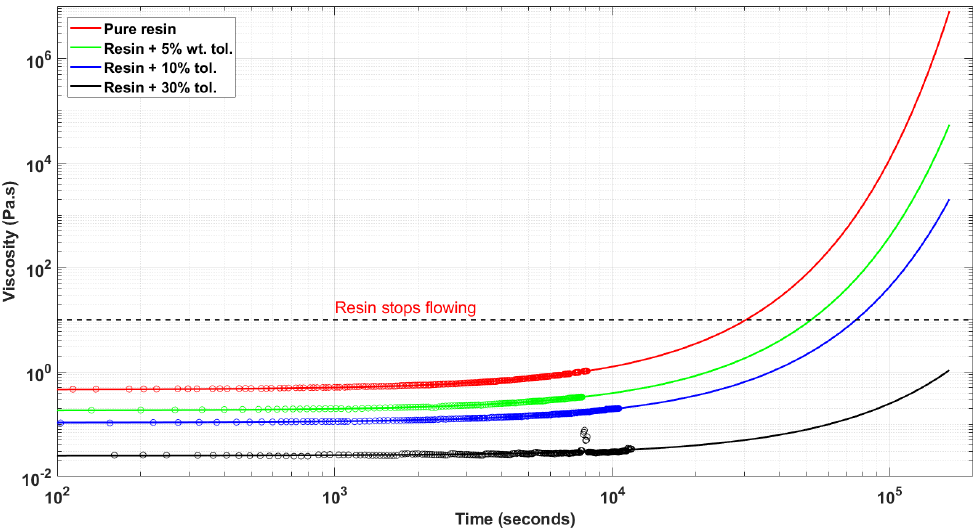
Figure 2. Resin viscosity vs. time. The gelation behavior was measured with a viscometer, under an average shear rate of 4 s − 1 , for 3–4 h, and Equation (1) was fitted to extrapolate the behavior. The viscosity was measured for four resin and toluene (tol.) compositions: (a) pure resin, (b) resin + 5 wt.% tol., (c) resin + 10 wt.% tol., and (d) resin + 30 wt.% tol. The composition (d)